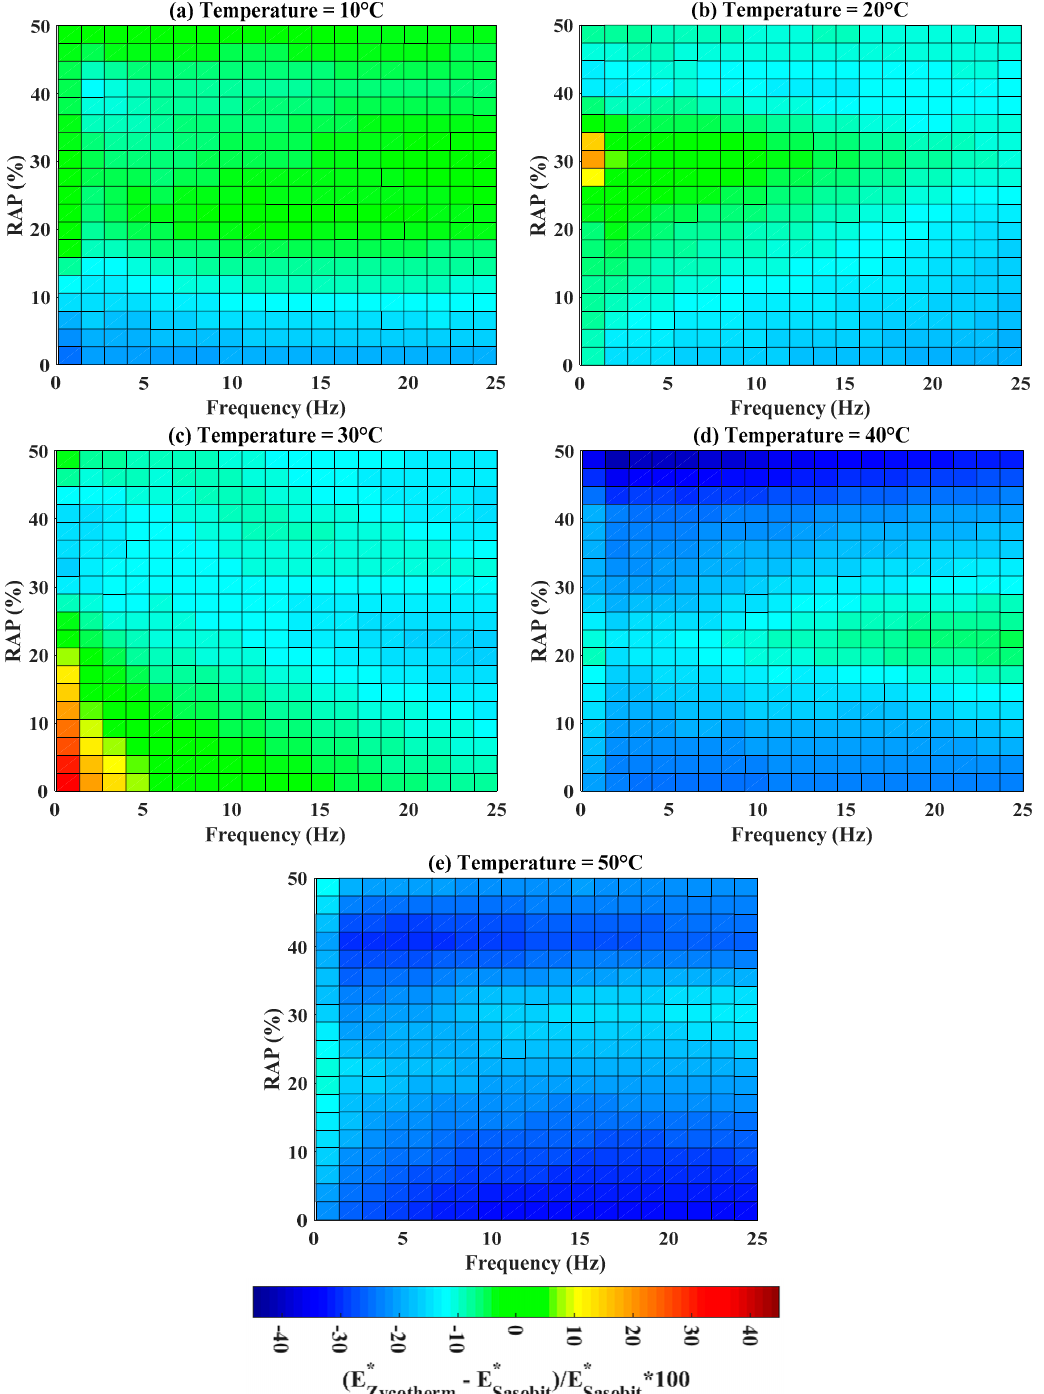
Figure 10. Box map sensitivity analysis and comparison of the two technologies at different %RAP, frequencies and temperatures ( a ) T = 10 °C; ( b ) T = 20 °C; ( c ) T = 30 °C; ( d ) T = 40 °C; and ( e ) T = 50 °C.